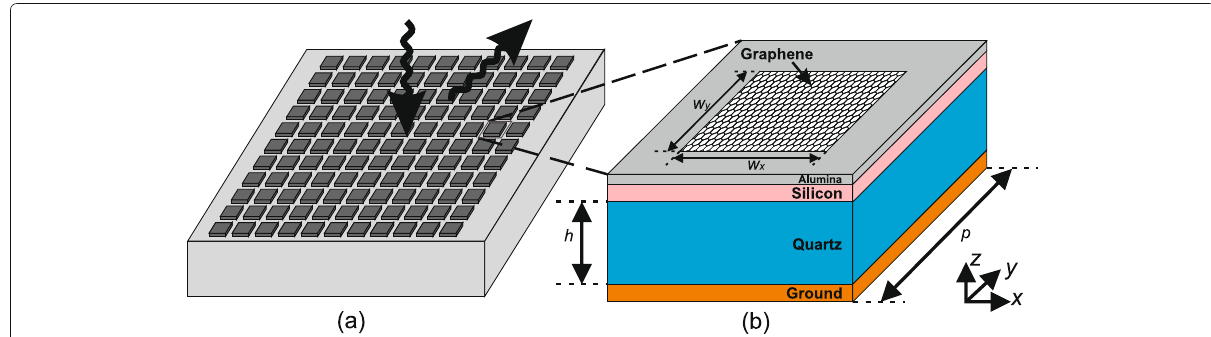
Fig. 1 Illustration of graphene metasurface and cell configuration. a Schematic of a graphene metasurface, which can steering the incoming electromagnetic waves by anomalous reflection. b Configuration of a graphene cell, which consists of multi-layered substrate and a mounted graphene patch of size w x × w y . A static gate voltage is applied between the graphene patch and the silicon layer to control the chemical potential